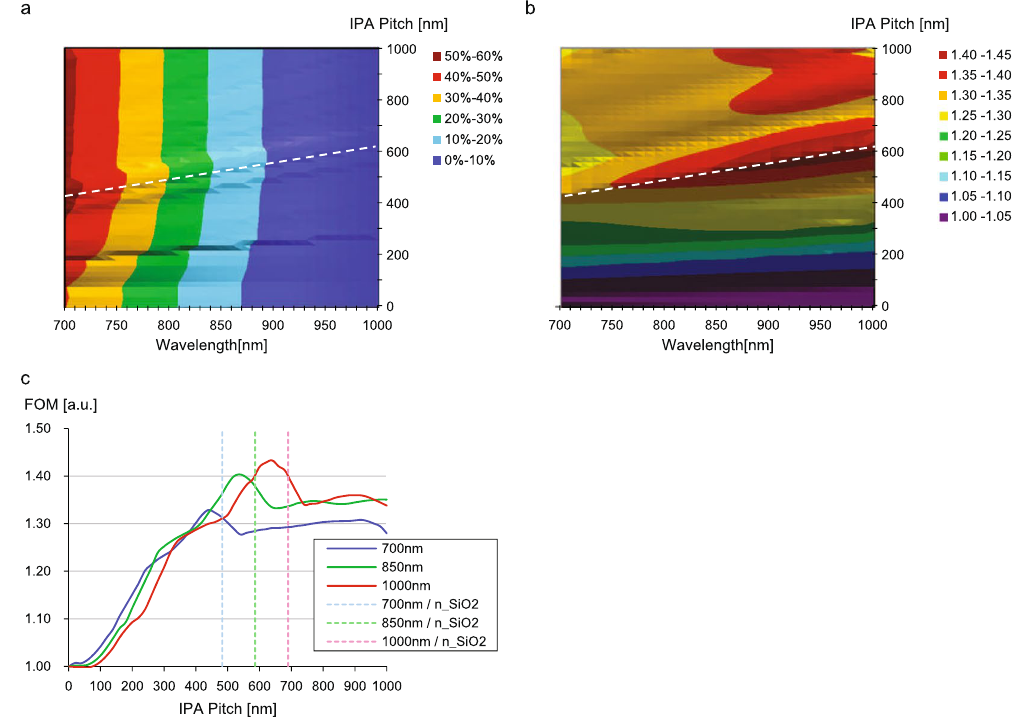
Figure 2. ( a ) Amount of light absorption of semi-infinite c-Si substrate with IPA by FDTD simulation. The horizontal axis is the wavelength of the incident light. The vertical axis is the pitch of IPA. Color indicates amount of the absorption of the c-Si which integrated from the surface to 3 μ m depth. ( b ) Normalized amount of light absorption (Figure of Merit) which is divided by the amount of absorption with flat surface case (corresponding to 0 nm pitch). White dashed lines in panels ( a ) and ( b ), the local maximum at each wavelength, slightly depends on the wavelength. ( c ) Vertical cuts of ( b ) at the wavelengths of 700 nm, 850 nm and 1000 nm. Light colored dashed lines are the effective wavelengths in SiO 2 . Here, the refractive index is assumed to Simulation for IPA size optimization. At first, we performed the FDTD simulations of bulk c-Si to eval- uate effectiveness of the structure. Here, c-Si is assumed to have semi-infinite thickness in the Z-direction, so that there is no reflection or diffraction from the bottom boundary of c-Si, and hence, it is possible to extract pure contribution of the diffractive surface only. We assumed SiO 2 buffer layer on the c-Si layer. Figure 2a shows the simulation results. The horizontal axis is the wavelength of incident light and the vertical axis is the pitch of the IPA structure. The color corresponds to the amount of absorption at each wavelength. The graph shows absorp- tion enhancement as the pitch increases. The enhancement has plateaus over a pitch size of around 500 nm. The simulated absorption of 3 μ m thick c-Si at 850 nm is calculated to be 12.5% with flat surface versus up to 16.5% with the IPA surface pitch of 400 nm (a 31% improvement). Figure 2b is the normalized absorption enhance- ment, FOM, defined as IPA surface absorption divided by the flat surface absorption at each wavelength. It is clearly seen that fine features exist in the graph. The most prominent one is that the white-dashed line has a local maximum at each wavelength. It has slight wavelength dependency and suggests that a 400 nm pitch is good for enhancement at λ = 700 nm sensitivity while the 600 nm pitch is good for λ = 950 nm. At λ = 850 nm, the best pitch is estimated to 540 nm and it has 18.1% absorption, corresponding to a FOM of 43%. Figure 2c shows the vertical cuts of Fig. 2b at λ = 700 nm, 850 nm and 1000 nm, respectively. Here, these wavelengths correspond to the effective wavelengths in the medium, λ n_SiO2 = 483 nm, 586 nm and 690 nm, respectively. They are slightly larger than the optimal pitch of 440 nm, 540 nm and 640 nm at each wavelength, suggesting that the optimal IPA